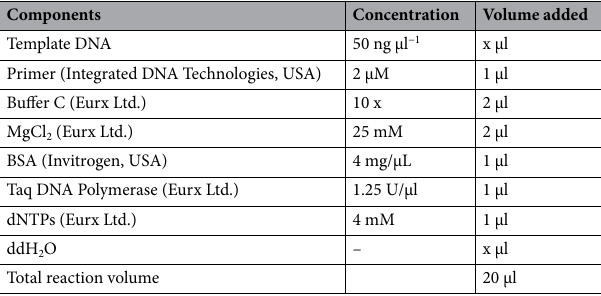
Table 1. PCR components in each total reaction volume.